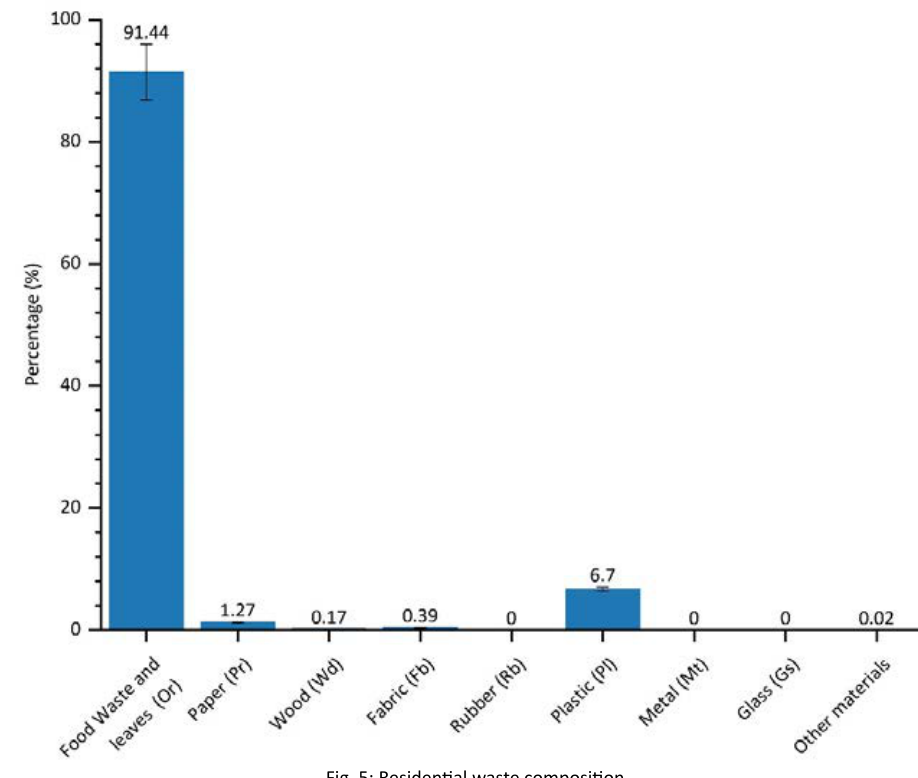
Fig. 5: Residential waste composition